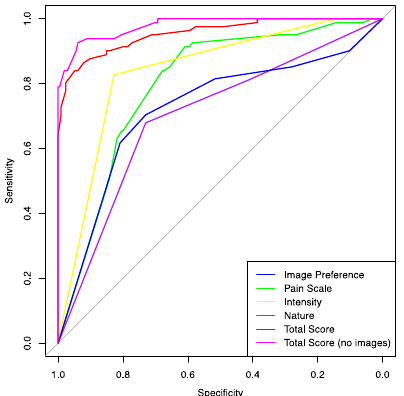
Figure 2. Receiver Operating Characteristics (ROC) curves for whole data set. The area under the curve (AUC) Total score = 0.955; Total score (no images) = 0.979; AUC Intensity = 0.841; AUC Pain scale = 0.799; AUC Image preference = 0.723; AUC Nature of pain = 0.702; AUC; area under the ROC curve is significantly greater than 0.5 ( p < 0.001).